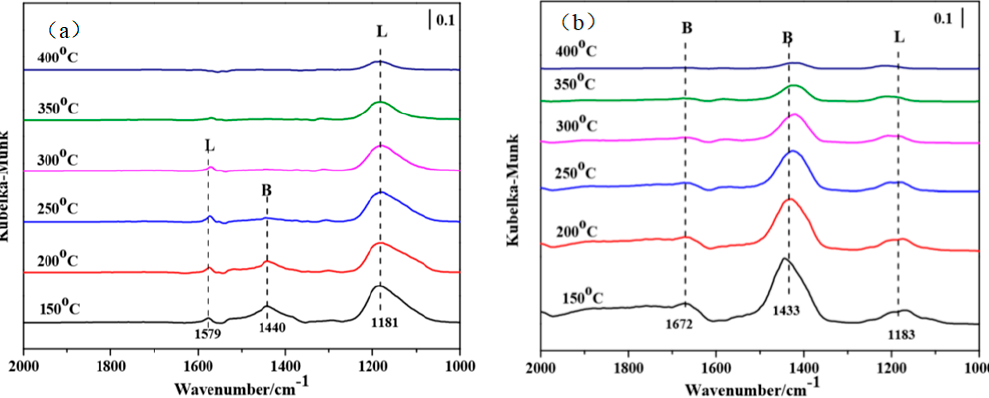
Figure 16. NH 3 adsorption in situ DRIFTS of ( a ) CeO 2 –TiO 2 (CT) and ( b ) MoO 3 /CeO 2 –TiO 2 (Mo/CT) catalyst [96].